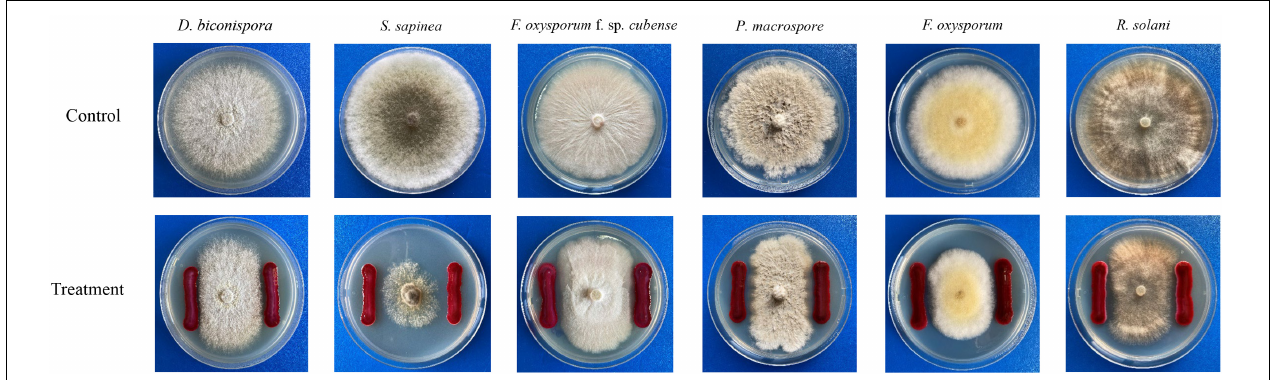
FIGURE 7 | The results of confrontation culture between S. marcescens JW-CZ and six different plant pathogens.